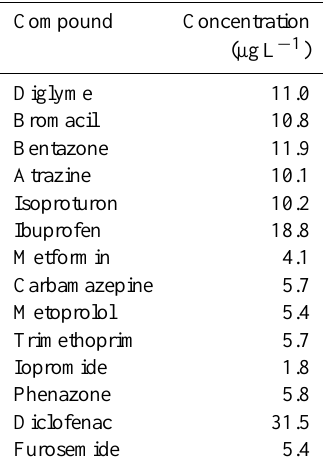
Table 3. Average concentration of spiked model compounds in